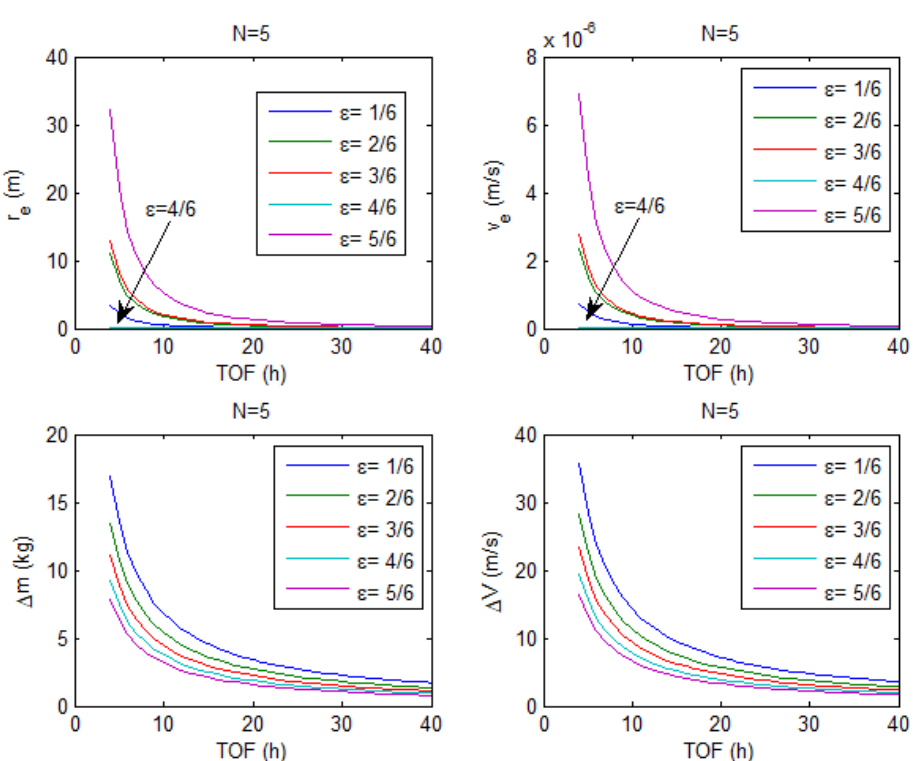
Figure 2. Control performance (baseline trajectory, = 5 N ).